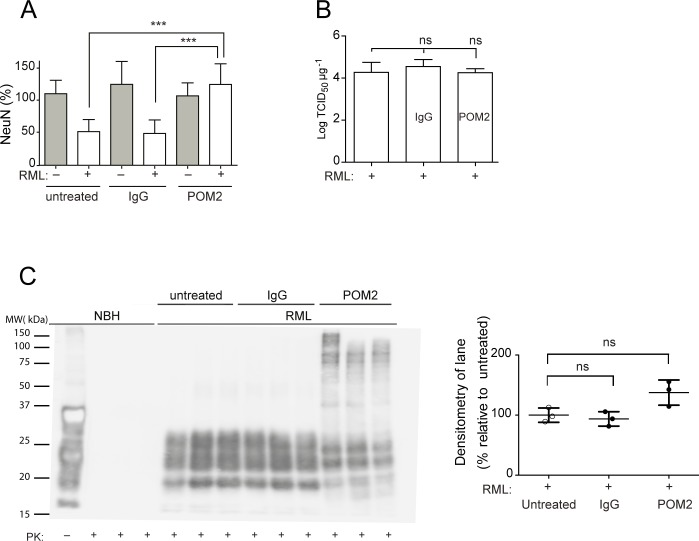
anti-FT antibody POM2 counteracts prion-induced neurotoxicity in COCS.(A) COCS prepared from tga20 mice were exposed to NBH (gray) or infected with RML prions (white), treated with pooled IgG or POM2 (335nM), and stained for NeuN at 44dpi. POM2 treatment afforded significant neuroprotection against prion infection; n = 9 biological replicates. (B) Prion titers of slice homogenates treated as in (A) were determined by SCEPA. POM2 treatment did not significantly reduce infectivity titers in prion-infected COCS. Data points represent the log of the median infectivity dose per mg of tissue culture (TCID50 mg-1) ± s.d.; n = 4 biological replicates. (C) COCS homogenates were treated as in (A), digested with proteinase K, and probed with the antibody POM1 for PrPSc. While the PrPSc bands between 18–30 kDa were somewhat decreased by POM2 treatment, there was a concomitant increase in higher-molecular PrP-immunoreactive moieties presumably representing SDS-resistant oligomers of PrPSc. Because of the different electrophoretic patterns of POM2-treated samples, we have opted to perform a quantification of the entire lane (right panel). POM2 treatment did not decrease the load of PK-resistant PrPSc; n = 3 biological replicates.